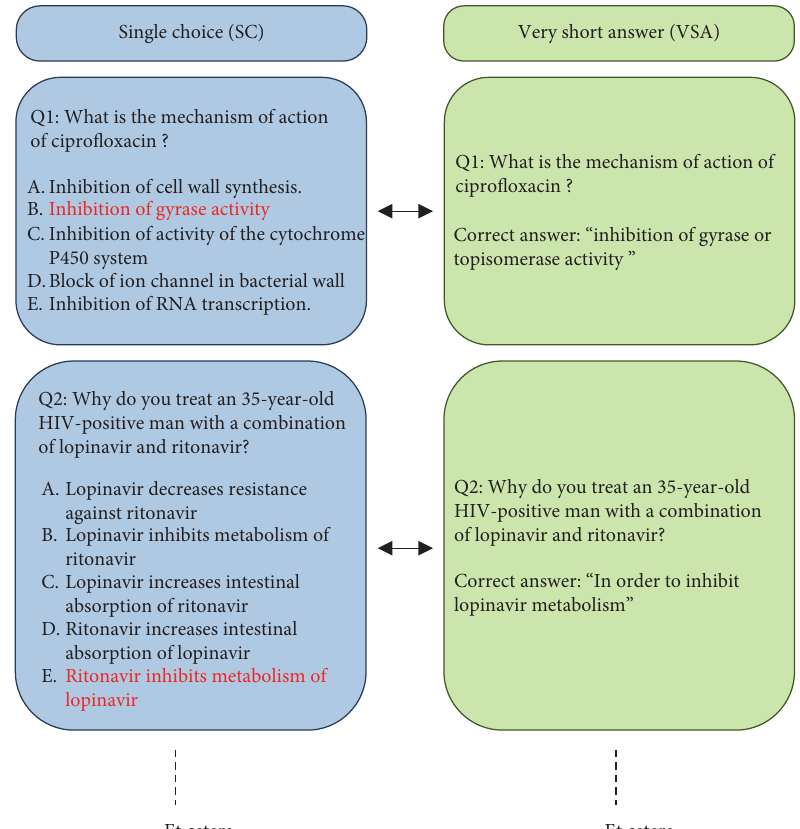
Figure 2: Two typical (in English translation from German) questions for single choice (SC) and very short answer